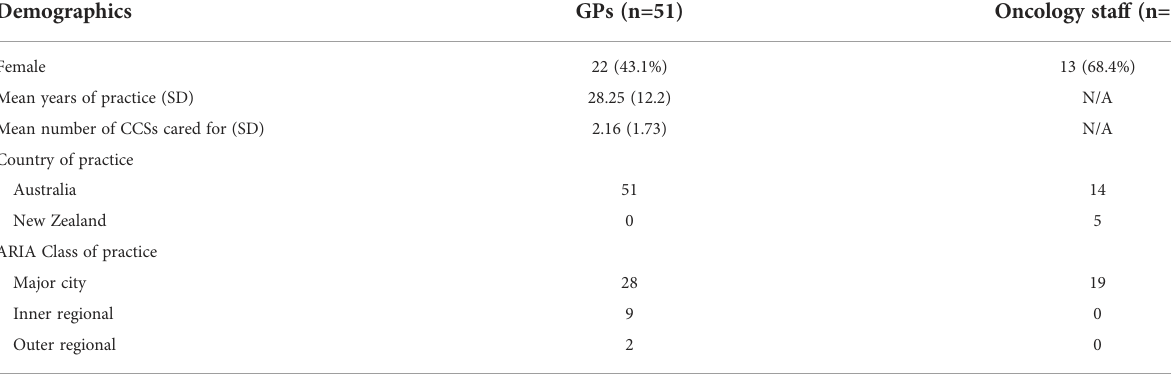
TABLE 1 Demographic information of GPs and oncology